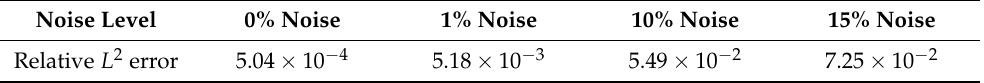
Table 2. The relative L 2 errors with respect to different noise levels for 1D